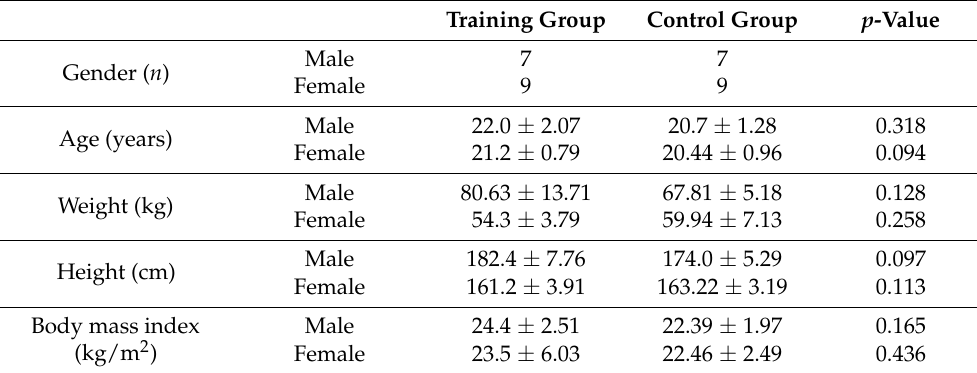
Table 1. Characteristics of